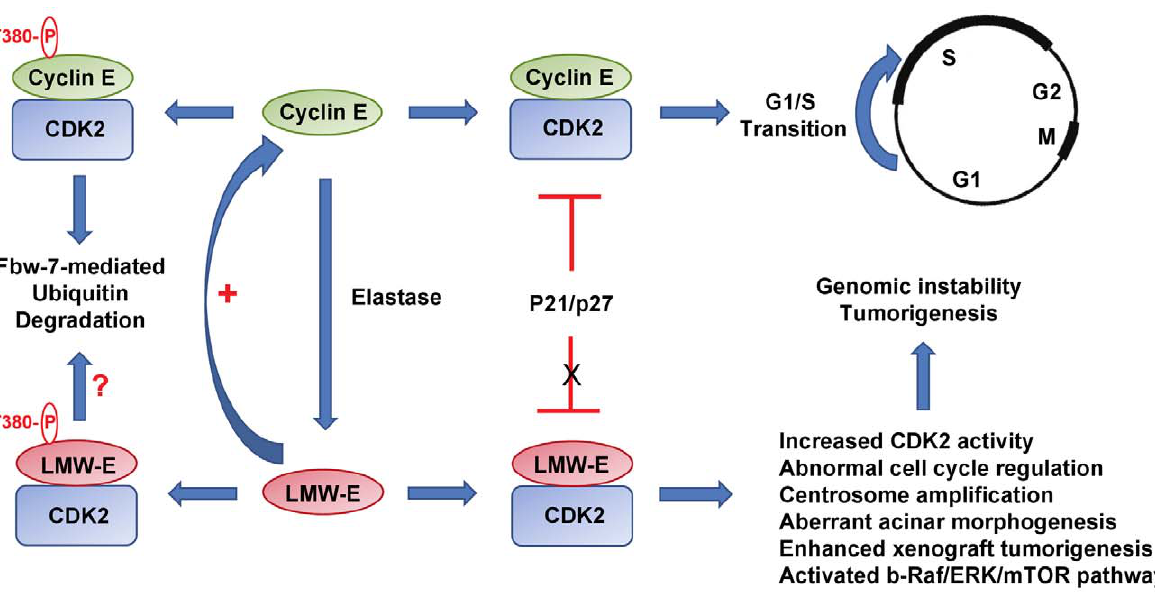
Figure 1. Low molecular weight cyclin E promotes tumorigenesis. In normal cells, cyclin E/CDK2 is tightly regulated and triggers the onset of S phase. In tumors, cyclin E undergoes proteolytic processing generating low molecular weight species that exhibit increased kinase activity and resistance to inhibition by cyclin kinase inhibitors p21/p27. The expression of LMW-E promotes aberrant acinar morphogenesis, centrosome amplification, and tumors associated with activation of the bRaf/ERK/mTOR pathway. LMW-E, low molecular weight cyclin